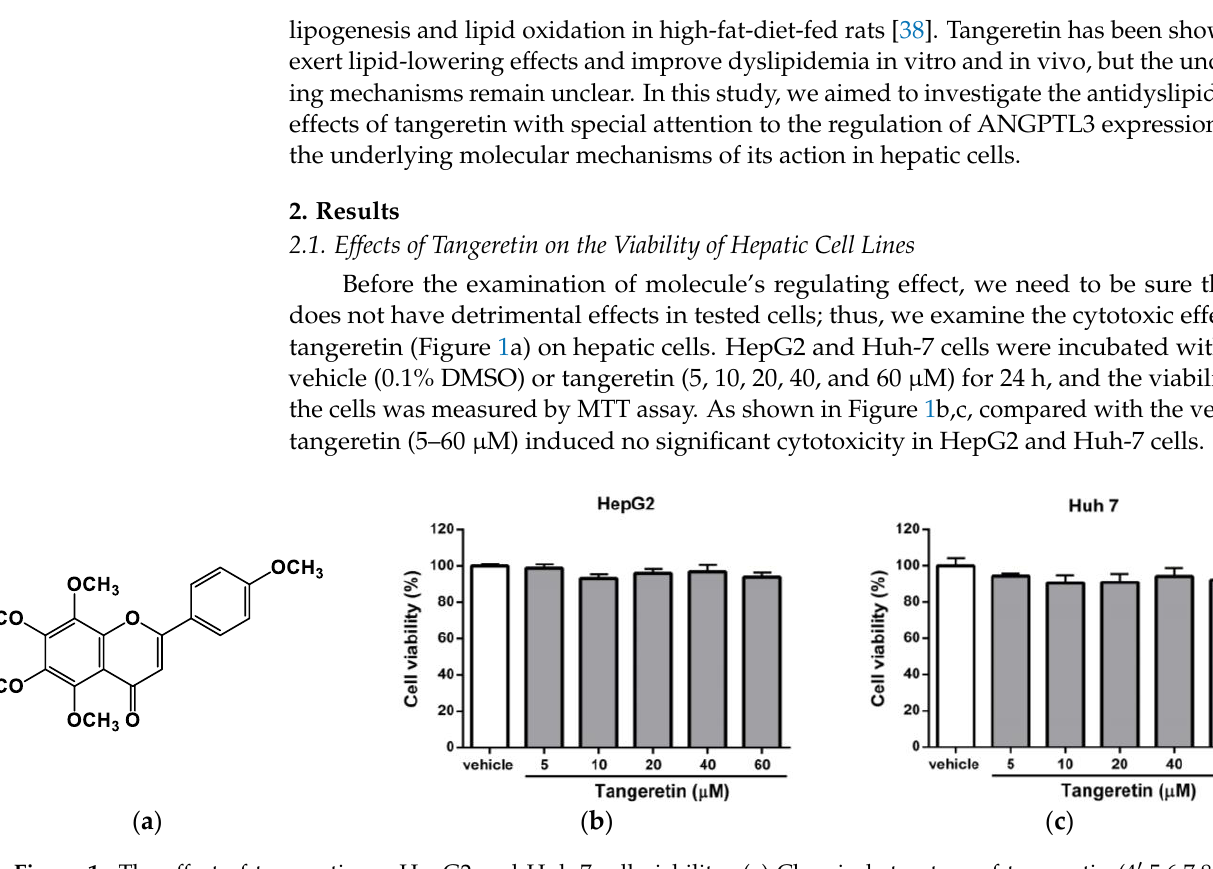
Figure 1. The effect of tangeretin on HepG2 and Huh-7 cell viability. ( a ) Chemical structure of tangeretin (4′,5,6,7,8-pentamethoxyflavone). ( b ) HepG2 and ( c ) Huh-7 cells were treated with vehicle (0.1% DMSO) or tangeretin (5, 10, 20, 40, and 60 μM) for 24 h. The viability of the cells was measured by MTT assay. The data are presented as the means ± SD of three independent experiments.